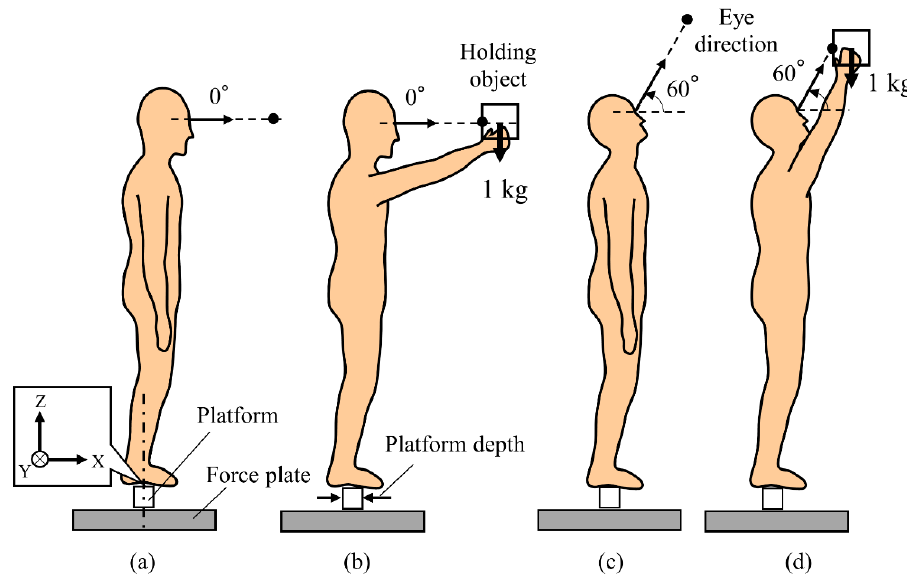
Figure 2. Schematic of experimental conditions: ( a ) standard, ( b ) object holding, ( c ) upward viewing, and ( d ) object holding and upward viewing.